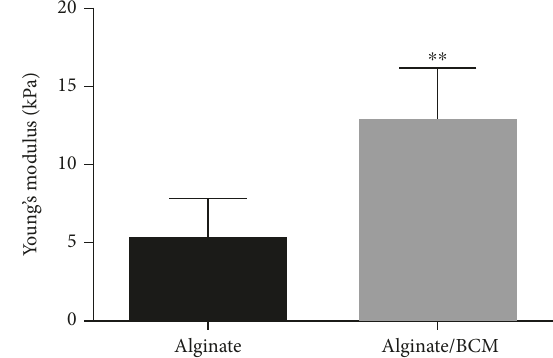
Figure 2: Young ’ s modulus of 1.2% alginate sca ff olds, crosslinked in CaCl and 1.2% alginate biofunctionalized with BCM. Data points 2 represent the mean from n = 10 ± SEM . The samples show signi fi cantly di ff erent moduli ( ∗∗ p < 0 05